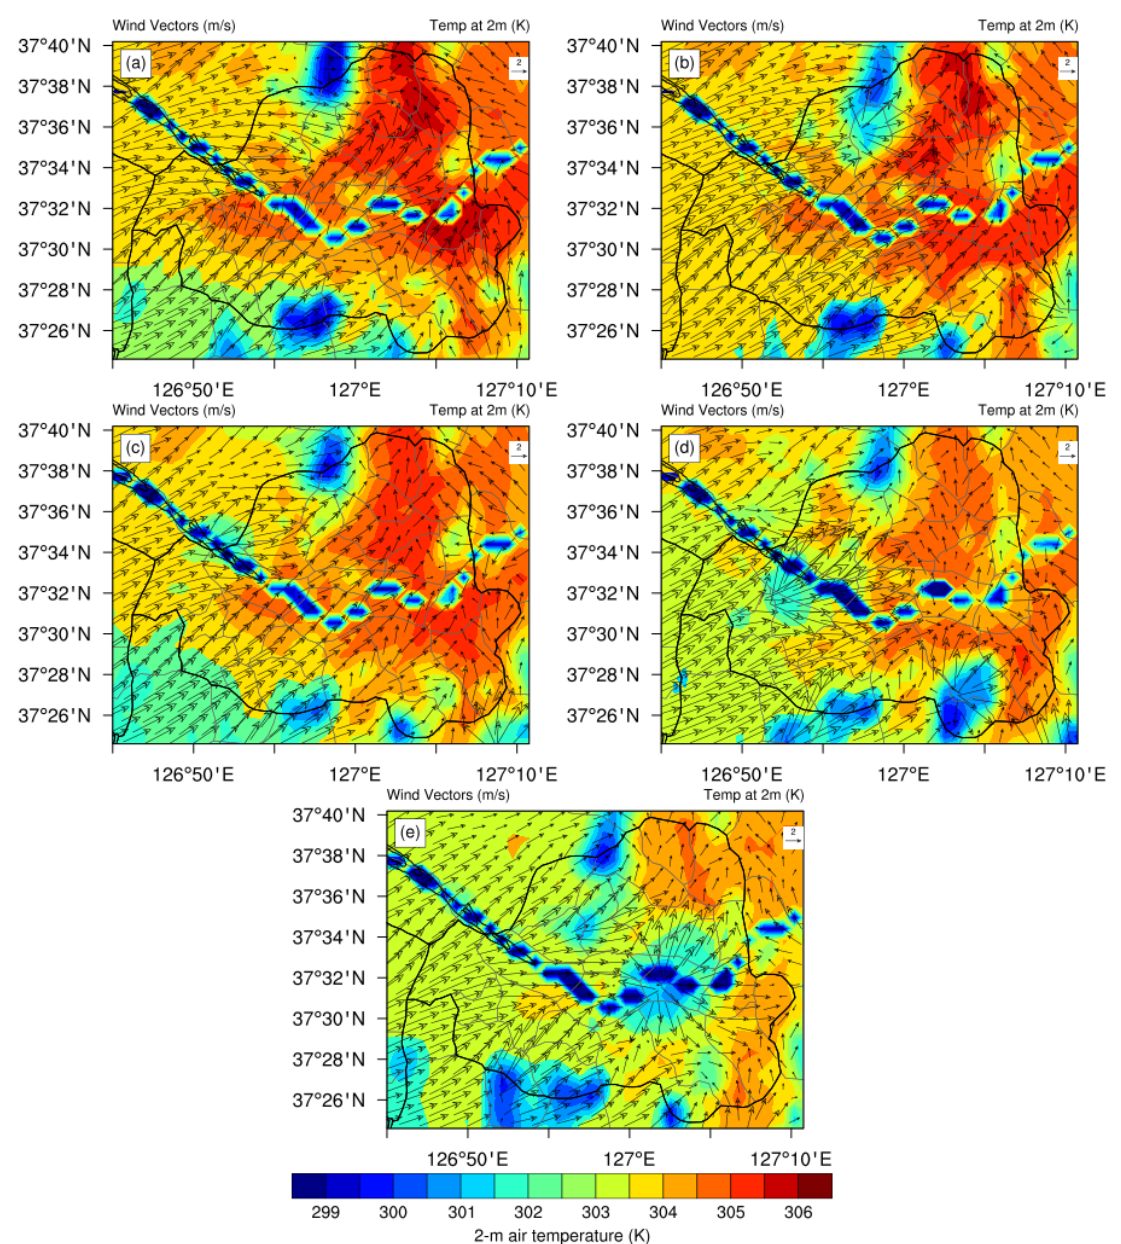
Figure 12. Horizontal distribution of 10 m wind vector and 2 m air temperature in analysis domain at 1600 LST in ( a ) CNTL, ( b ) LB, ( c ), NA, ( d ) NALB, and ( e ) NOURBAN simulation.